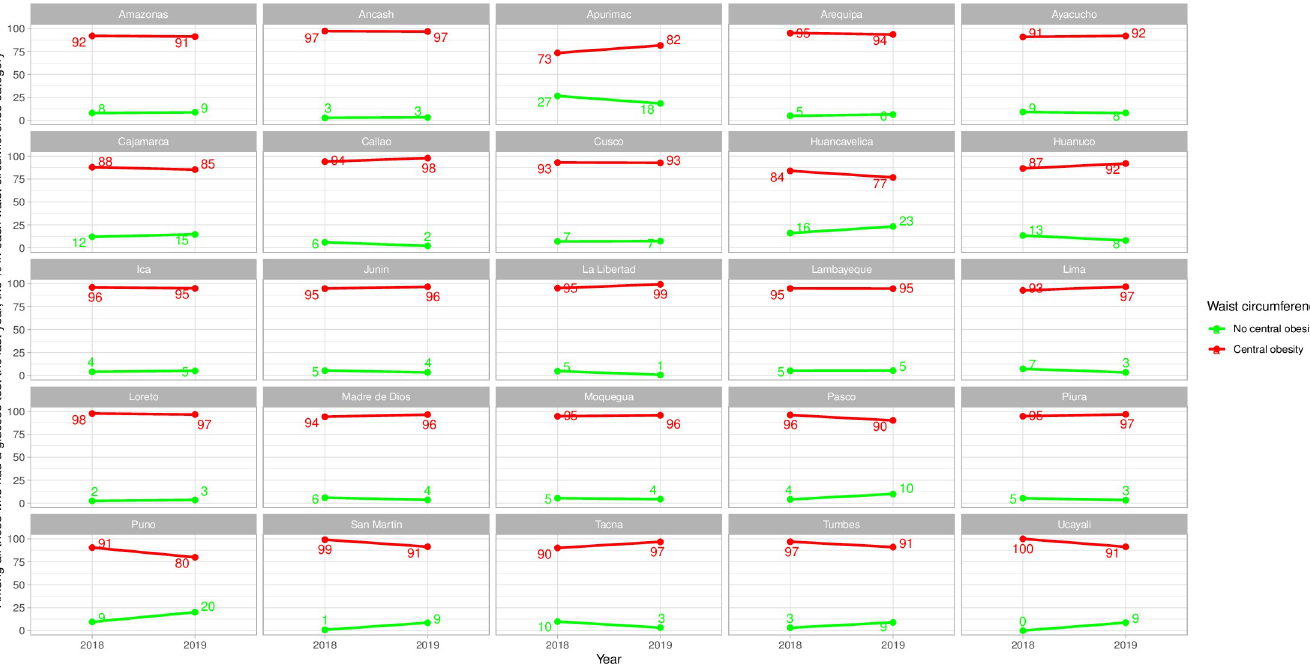
PLOS ONE | https://doi.org/10.1371/journal.pone.0256809 August 27,